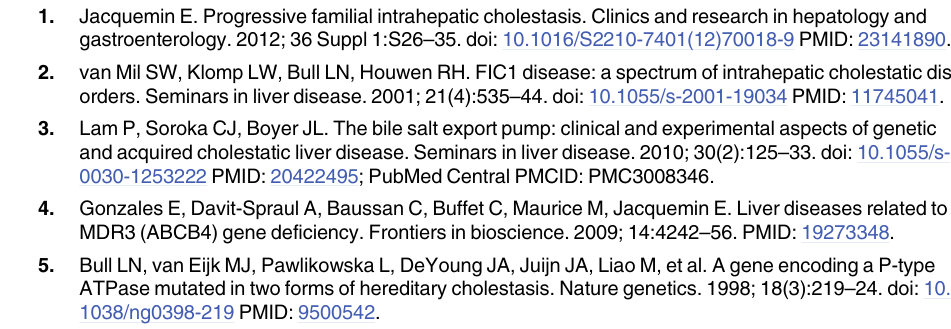
S1 Table. Primers for PCR and qPCR amplification of ATP8B1 , ABCB11 and ABCB4